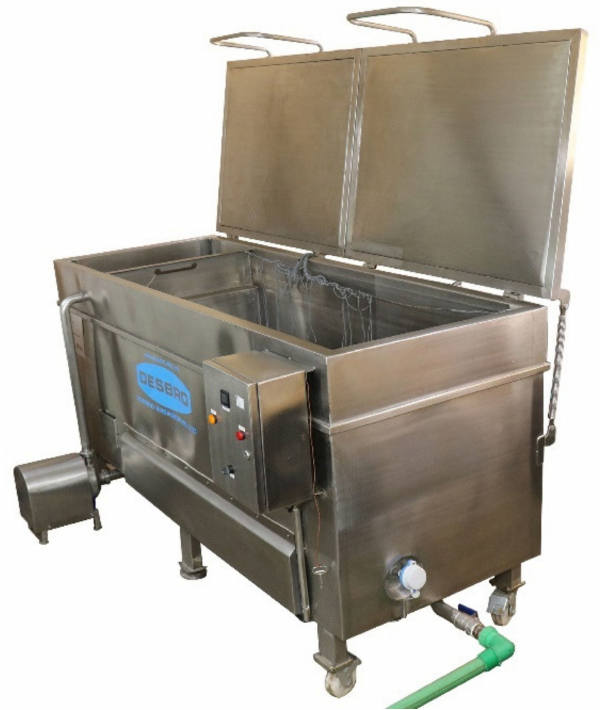
Figure 1. Insulated stainless steel hot water treatment machine. Lids were only in use during the water heating process and opened once the treatment